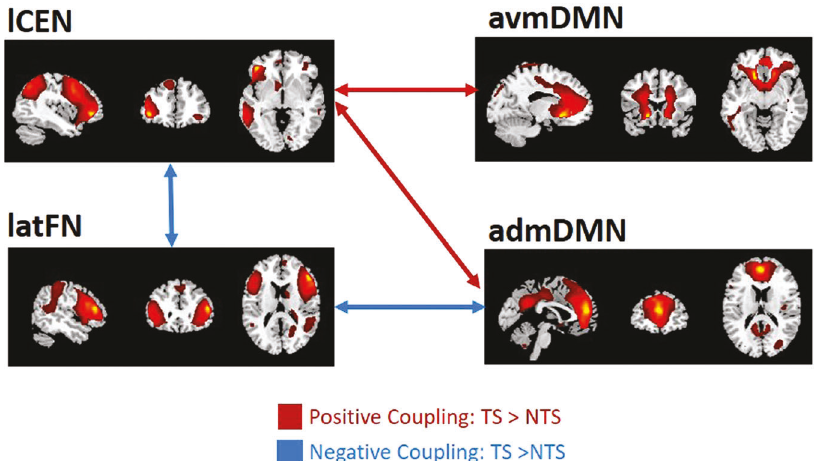
Fig. 3 Group differences in between-network connectivity patterns. The torture group showed increased positive functional connectivity between the lCEN and admDMN and avmDMN compared to the NTS group (represented by red arrows), and greater negative functional connectivity between the lCEN and latFN and latFN and admDMN (represented by blue arrows) ( p < 0.05 FDR-corrected). that is consistent with studies in torture survivors that have demonstrated grey matter volume reductions across the brain including the prefrontal cortex [22, 23]. As we did not examine structural differences in this study, we cannot attribute lCEN functional alterations to structural changes, but at present, this study clearly points to lCEN functional changes in the TS group and perturbations in coupling with medial networks.